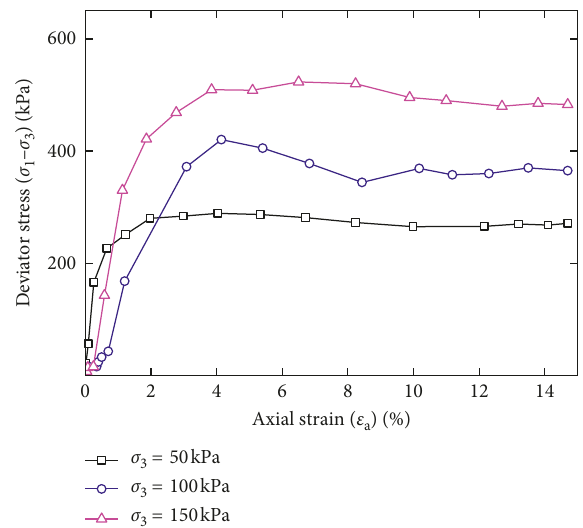
Figure 6: Deviator stress-axil strain curves under different con- fining